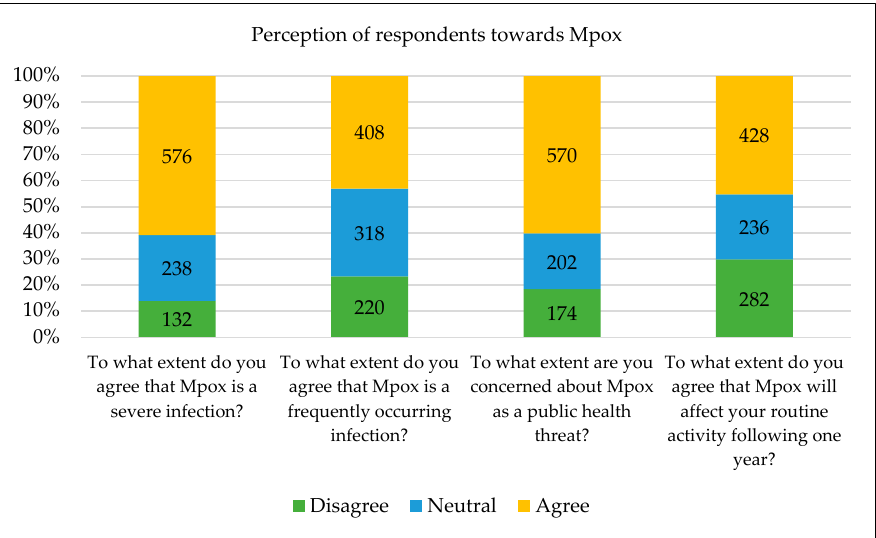
Figure 1. Perception of respondents towards Mpox.